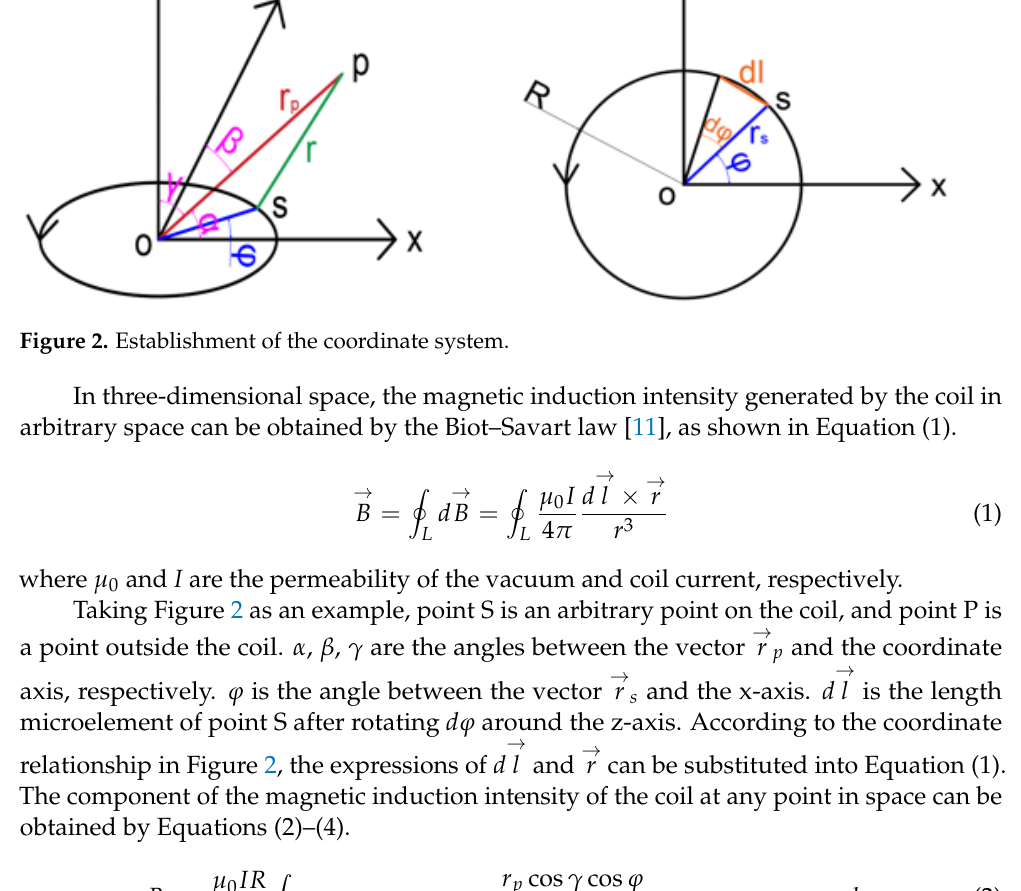
relationship in Figure 2, the expressions of d